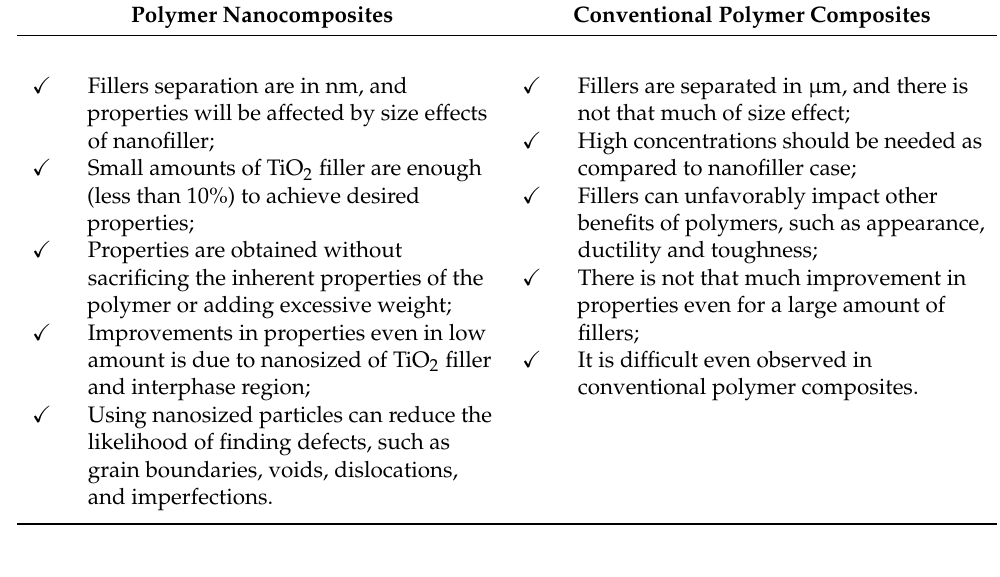
Table 4. Advantages of polymer nanocomposites over conventional polymer composites.